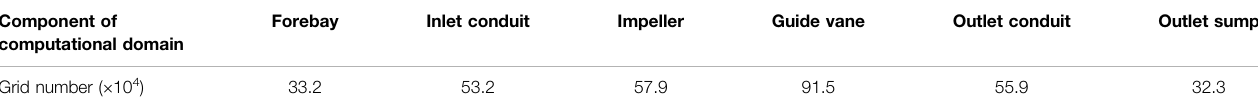
TABLE 1 | Grid number of each component of the computational domain of the pump device. Component of computational domain